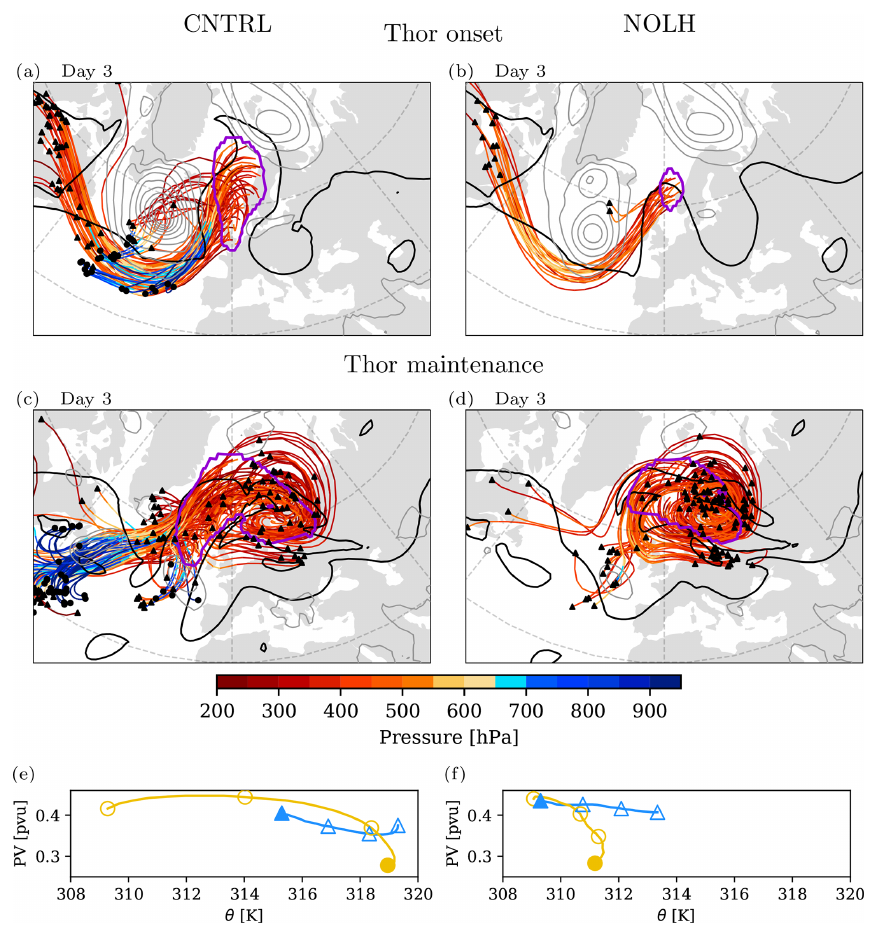
Figure 5. Upper-level 2pvu contour (black line), SLP (gray contours, from 1000hPa every − 5hPa), and blocking region (violet contour for upper-level PV anomaly of − 1pvu) for the (a, c) CNTRL and (b, d) NOLH simulations for the case Thor onset (a, b) and Thor maintenance (c, d) . The 72h backward trajectories started in the blocking region at 00:00UTC 4 October 2016 in the onset simulations and at 00:00UTC 13 October 2016 in the maintenance simulations and are shown as colored lines, with color indicating pressure (hPa). The black circles and triangles show the location of the heated ( (cid:49)θ > 2K) and quasi-adiabatic ( (cid:49)θ < 2K) trajectories 3d prior to arrival in the blocking, respectively. (e, f) Median temporal evolution of θ and PV along heated (yellow) and quasi-adiabatic (blue) blocking trajectories for the (e) CNTRL and (f) NOLH simulations. The evolution was calculated from all trajectories during the entire blocking lifetime of Thor onset and Thor maintenance cases. Filled markers show the median for each airstream at the time of the arrival in the blocking region, and open markers show medians at days − 1, − 2, and − 3 before arriving in the